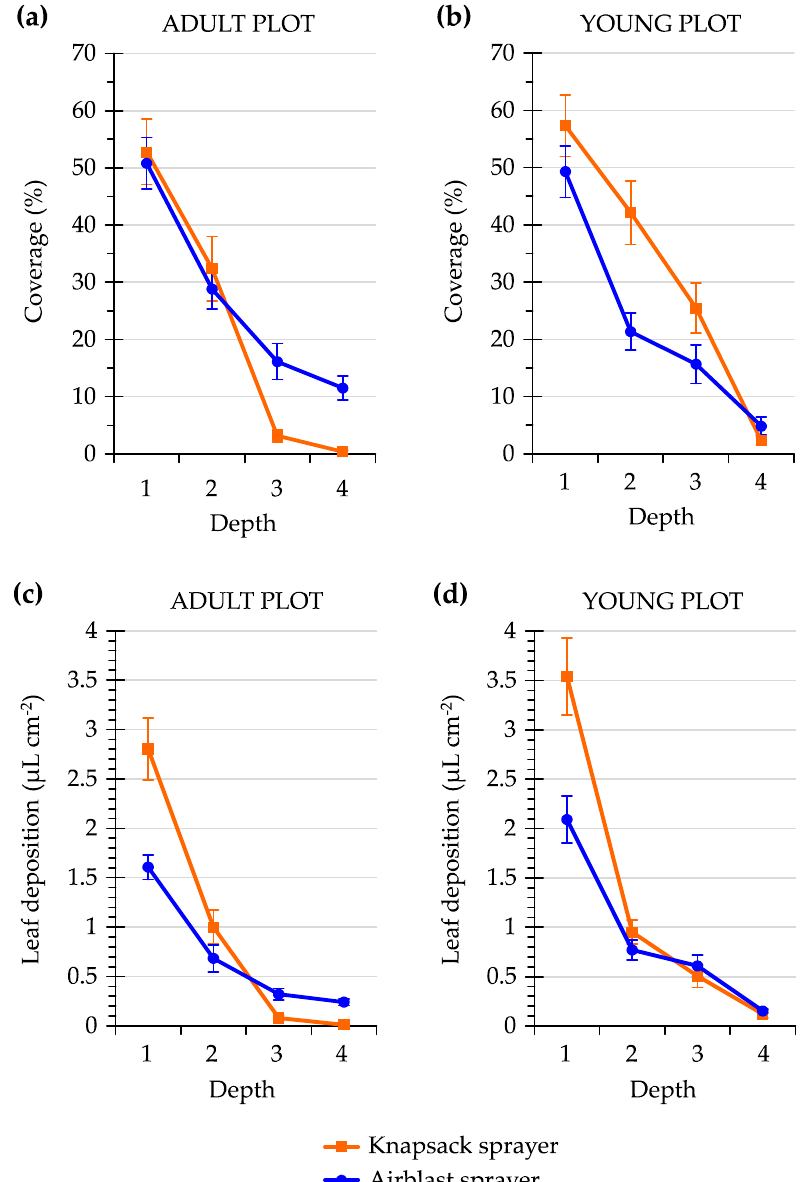
Figure 10. “Sprayer × Depth” interaction for coverage (%) (mean (s.e.)) for the ( a ) adult and ( b ) young plots, and for leaf deposition ( μ L cm − 2 ) (mean (s.e.)) in the ( c ) adult and ( d ) young plots.